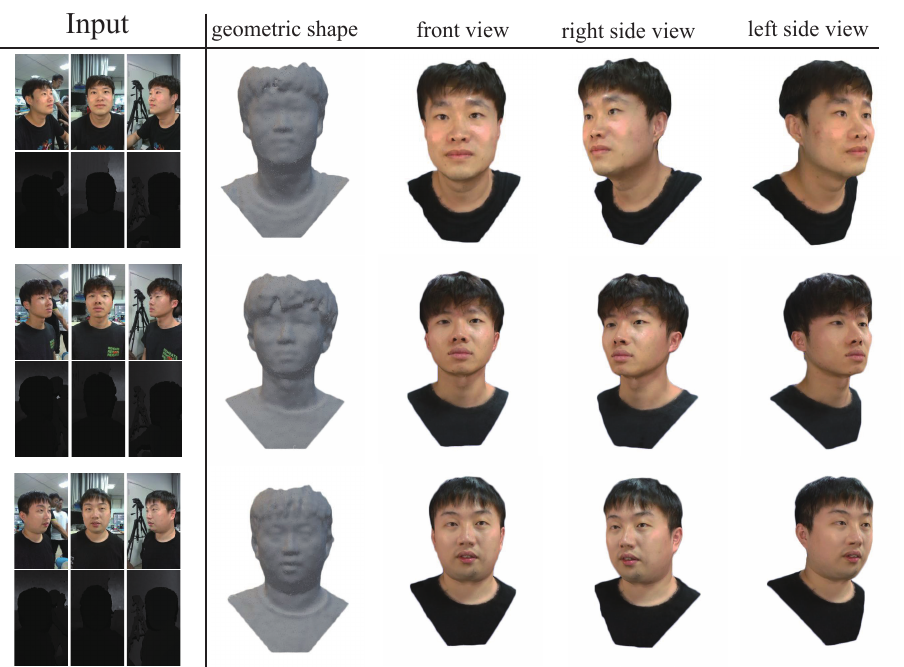
Figure 8. Face reconstruction results from aligned RGB-D image pairs using our approach. The first column contains the input RGB and depth image pairs, and our geometric shapes are shown in the second column. Columns 3–5 show our texture geometry results from different views.